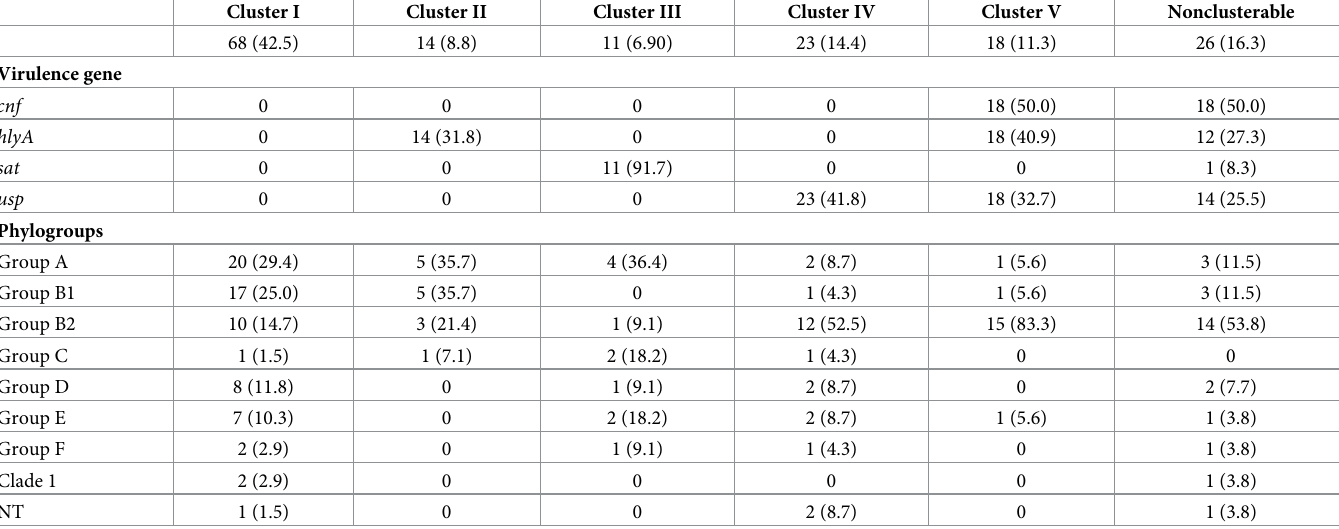
Table 10. Hierarchical clustering for distribution of toxin virulence genes among E . coli isolated from ASB cases, total